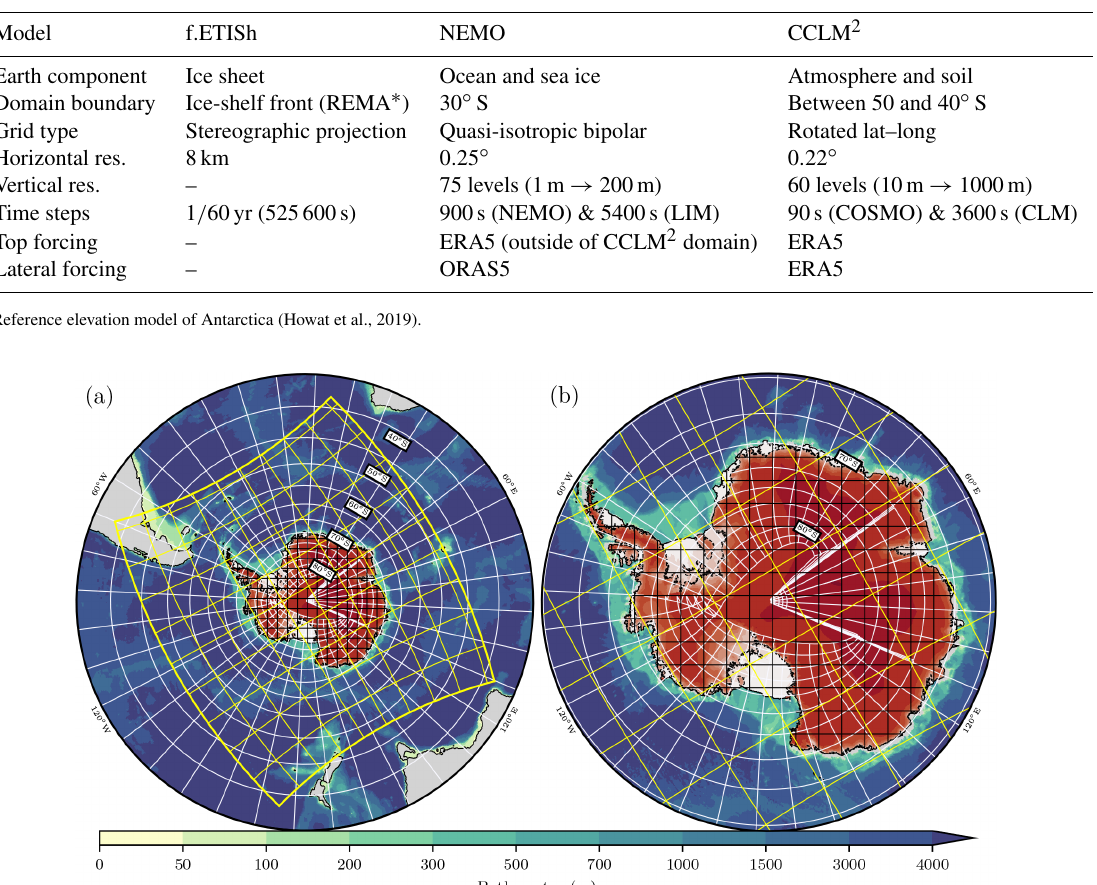
Table 3. Summary of PARASO model setups. “res.” stands for “resolution”.